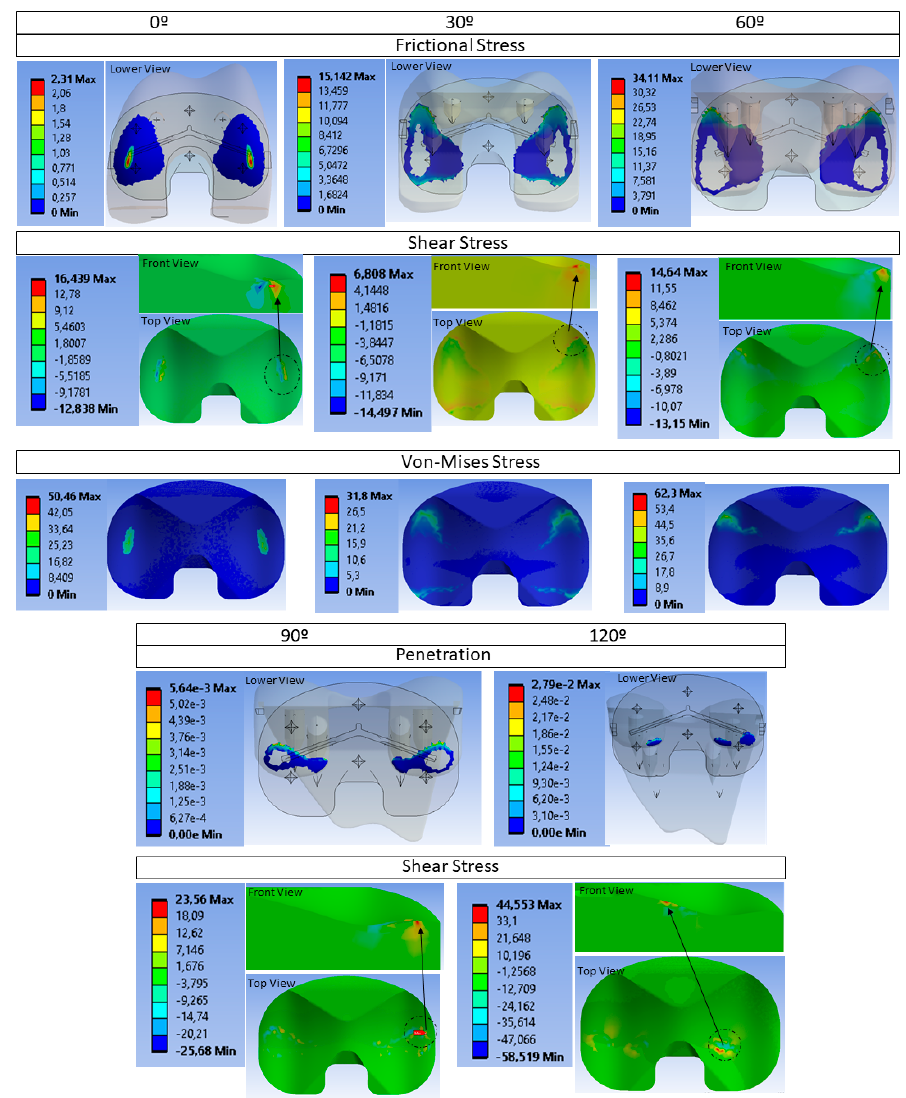
Figure 8. Results of the FEM simulation. ( Top ) Stress frictional (lower femoral part viewpoint of the observer), shear stress and von Mises stress (top tibial part viewpoint of the observer) to flexion angles 0 ◦ ; 30 ◦ ;60 ◦ . ( Bottom ) Penetration contact and shear stress to 90 ◦ ;120 ◦